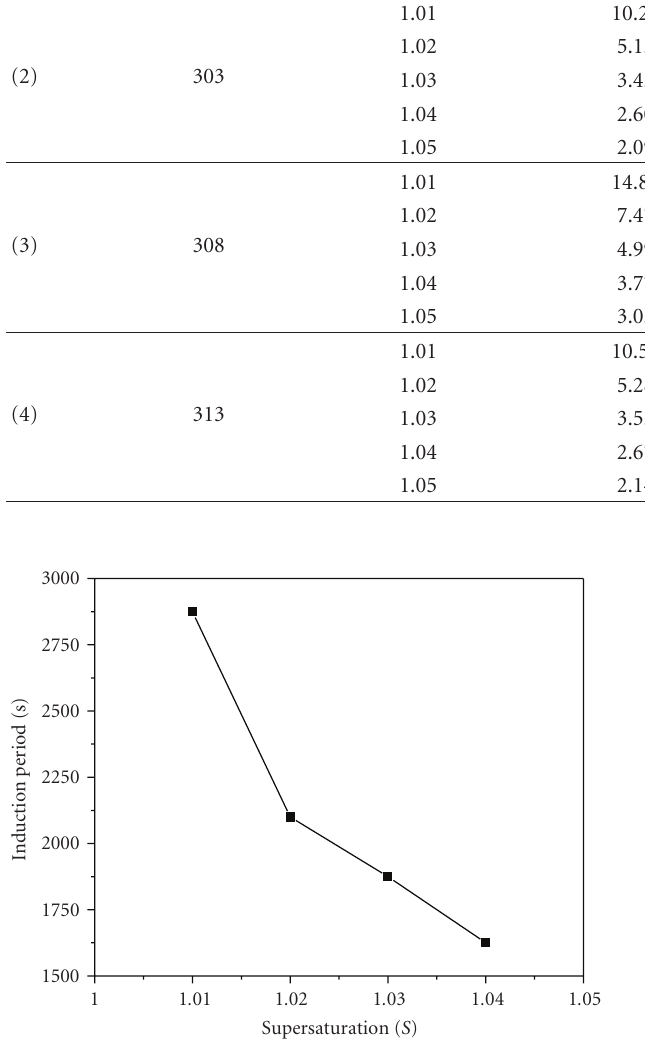
Figure 9: Induction period versus supersaturation for